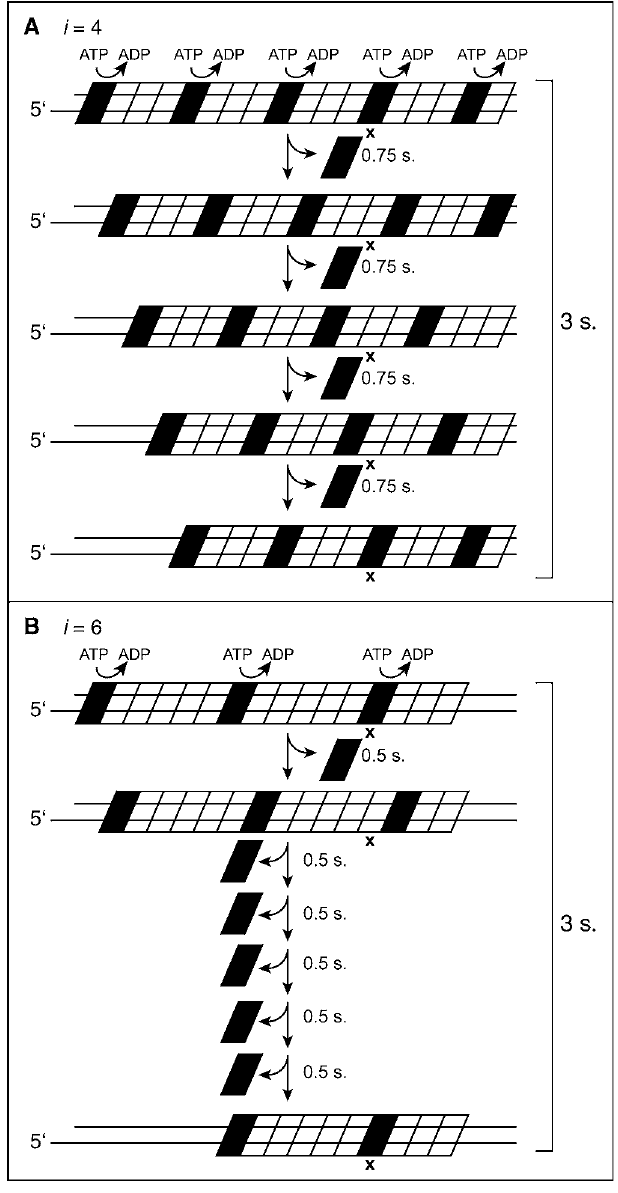
Figure 3. Coupled Waves of ATP Hydrolysis in RecA Filaments (A) The interval between hydrolyzing monomers (i) is set at four monomers. The dark monomers are those at the hydrolytic step of their ATP hydrolytic cycle. Each monomer within the filament (e.g., the one marked with an ‘‘ X ’’ ) is hydrolyzing an ATP every 3 s, so that a new wave must reach it within that time span. If i = 4 monomers, the waves must move every 0.75 s. The last wave, at the disassembling end, results in dissociation. (B) The same considerations in (A) for i = 4 monomers are illustrated for i = 6 monomers. DOI: